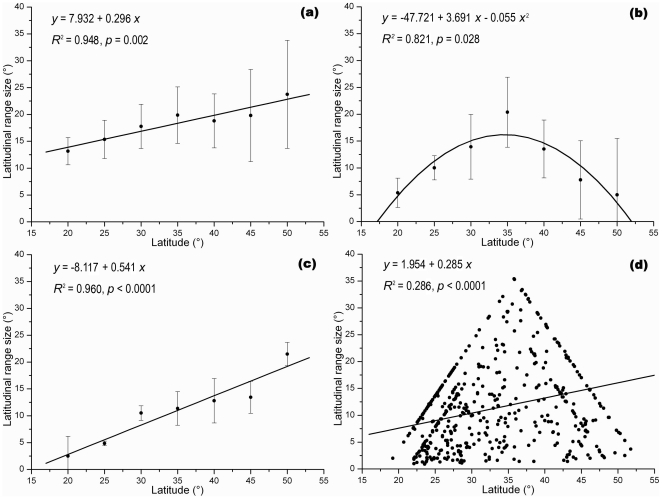
Mean latitudinal range size of terrestrial mammals among latitudes in China.Solid lines represent the fitted correlations between mean latitudinal range sizes and latitudes: (a) Steven's method (sample size within each 5° band (left to right): 206, 233, 201, 161, 161, 124, 56); (b) mid-point method (sample size within each 5° band (left to right): 114, 138, 83, 64, 74, 37, 5); (c) Pagel's method (sample size within each 5° band (left to right): 37, 119, 94, 65, 45, 86, 69); (d) cross-species method (total sample size was 515).